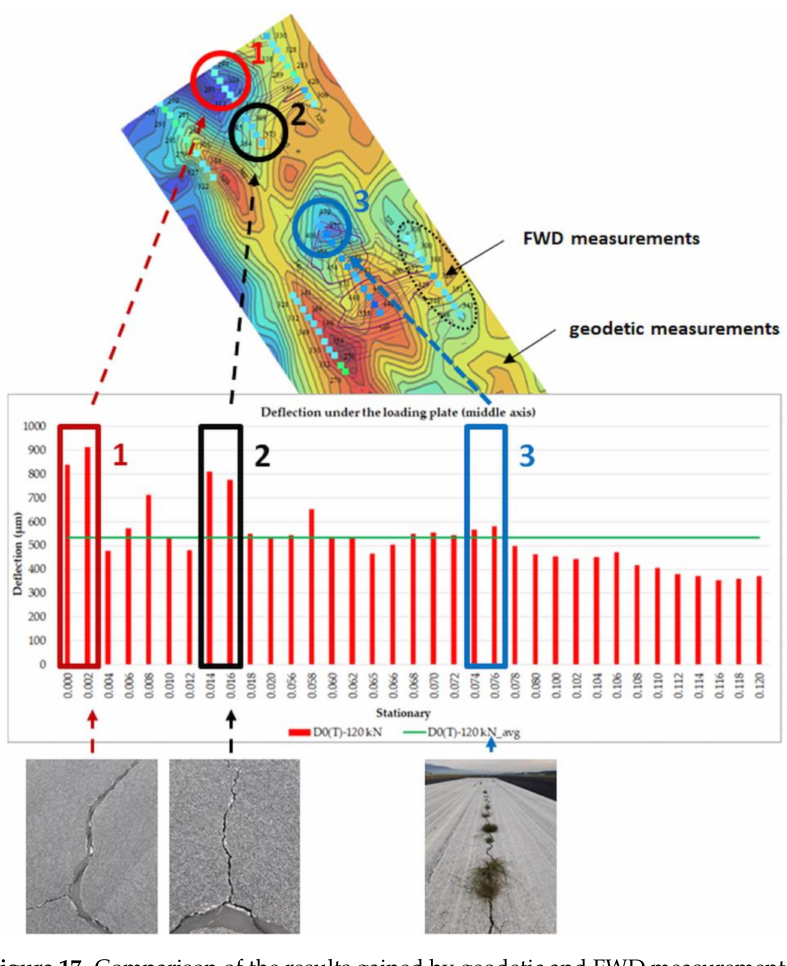
Figure 17. Comparison of the results gained by geodetic and FWD measurements.